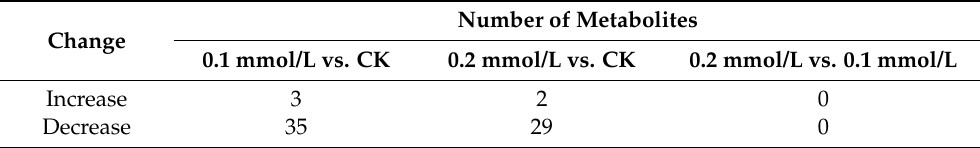
Table 4. Number of increased or decreased metabolite levels among the 197 identified metabolites in the mycelia of Epichloë sinensis Se-treated (0.1 and 0.2 mmo/L Na 2 SeO 3 ) and untreated groups from 4 to 8 weeks of cultivation.